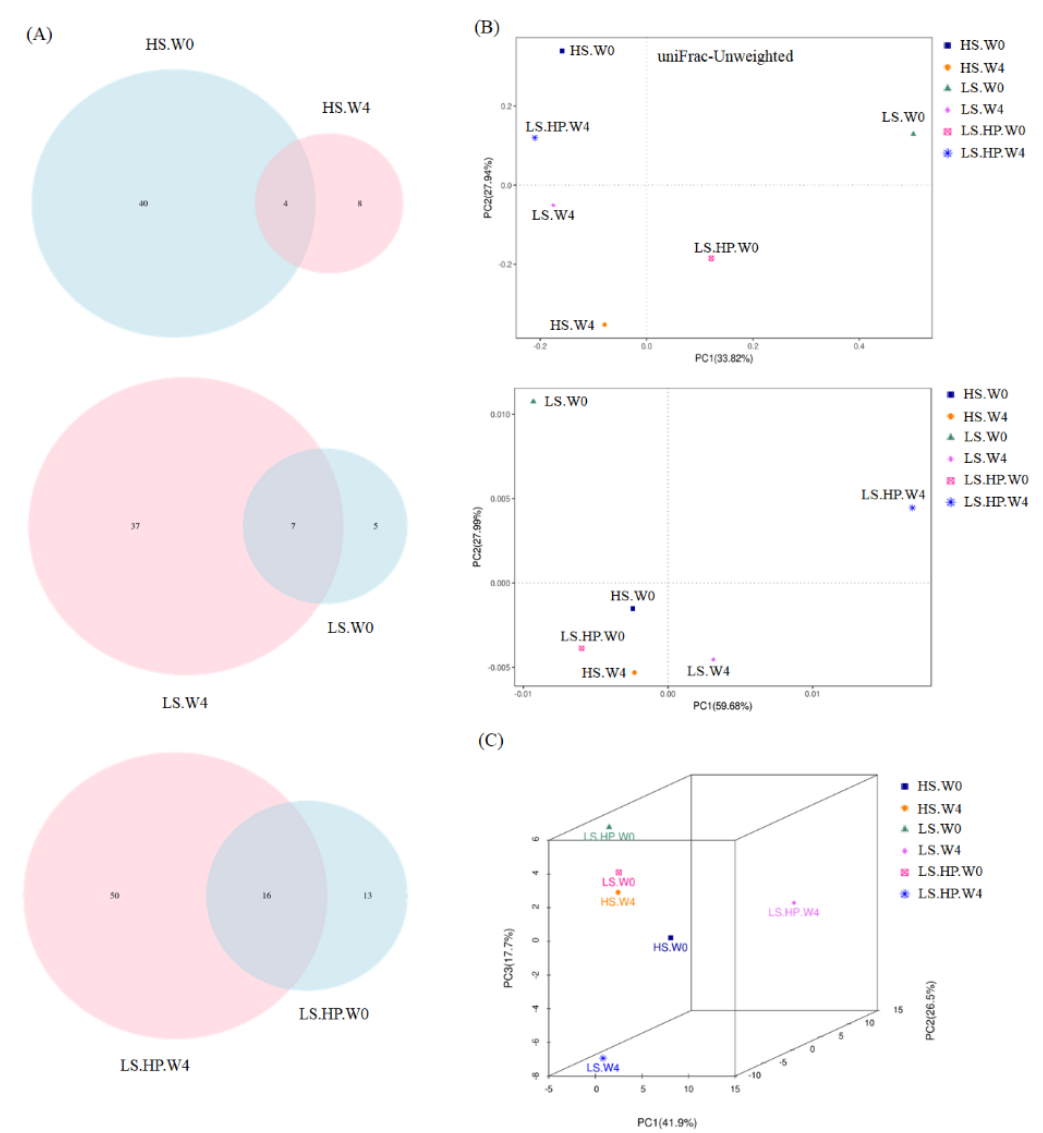
Figure 5. (A) Venn diagrams of analysis for the fungal OTUs, ( B ) the unweighted and weighted uniFrac PCoA plots of beta-diversity obtained from analysis of fungal microbiota in high-salt (HS), low-salt (LS), and low-salt high-pressure (LS-HP) soy sauce during fermentation. ( C ) PCA assay for fungal microbiota in high-salt (HS), low-salt (LS), and low-salt high-pressure (LS-HP) soy sauce during fermentation.